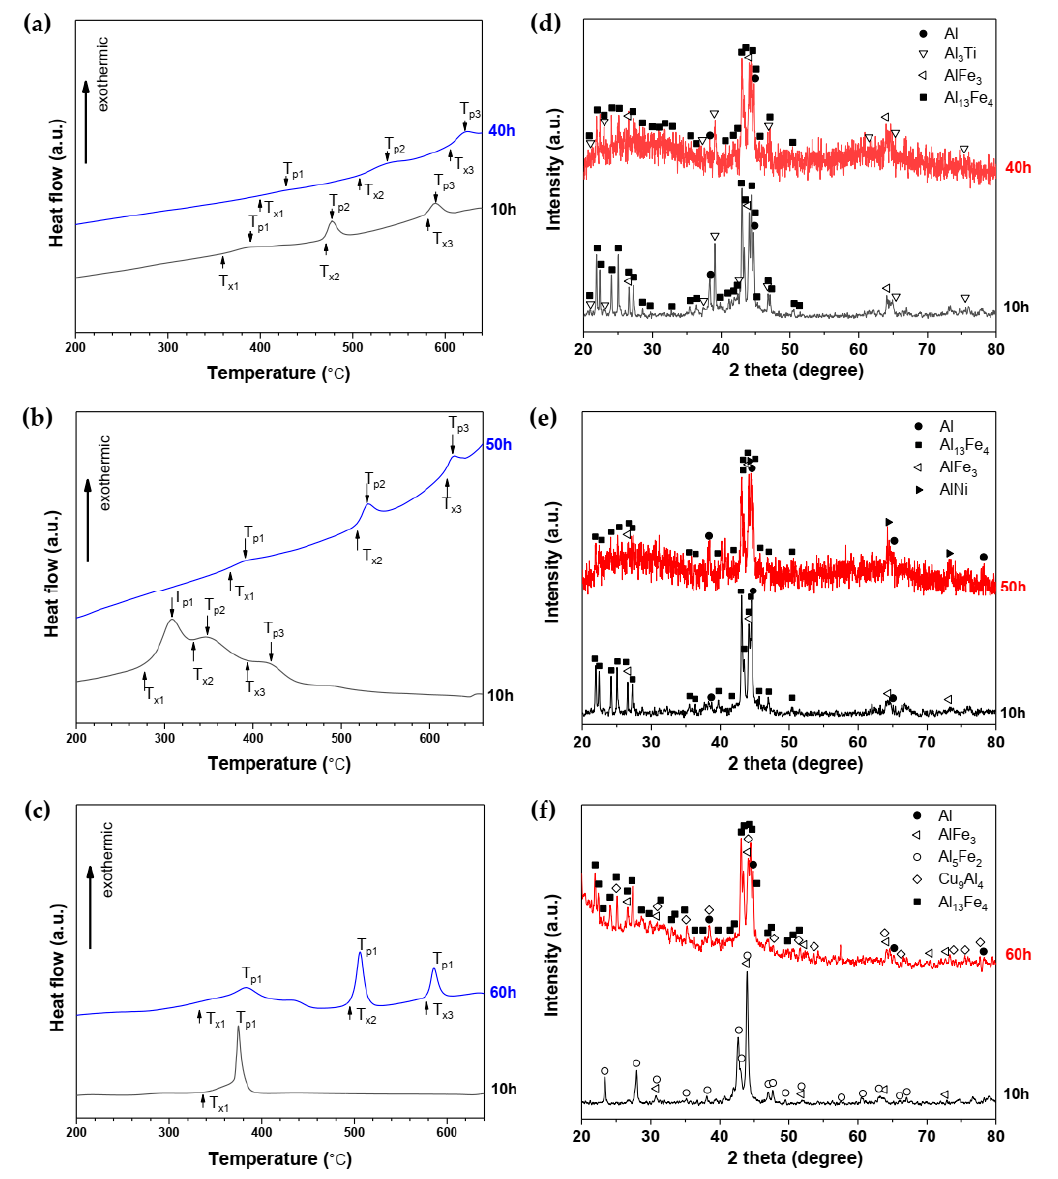
Figure 3. DSC curves of as-milled ( a ) Al 82 Fe 16 Ti 2 , ( b ) Al 82 Fe 16 Ni 2 , and ( c ) Al 82 Fe 16 Cu 2 alloy powders and their XRD patterns after DSC examination of ( d ) Al 82 Fe 16 Ti 2 , ( e ) Al 82 Fe 16 Ni 2 , and ( f ) Al 82 Fe 16 Cu 2 alloys.